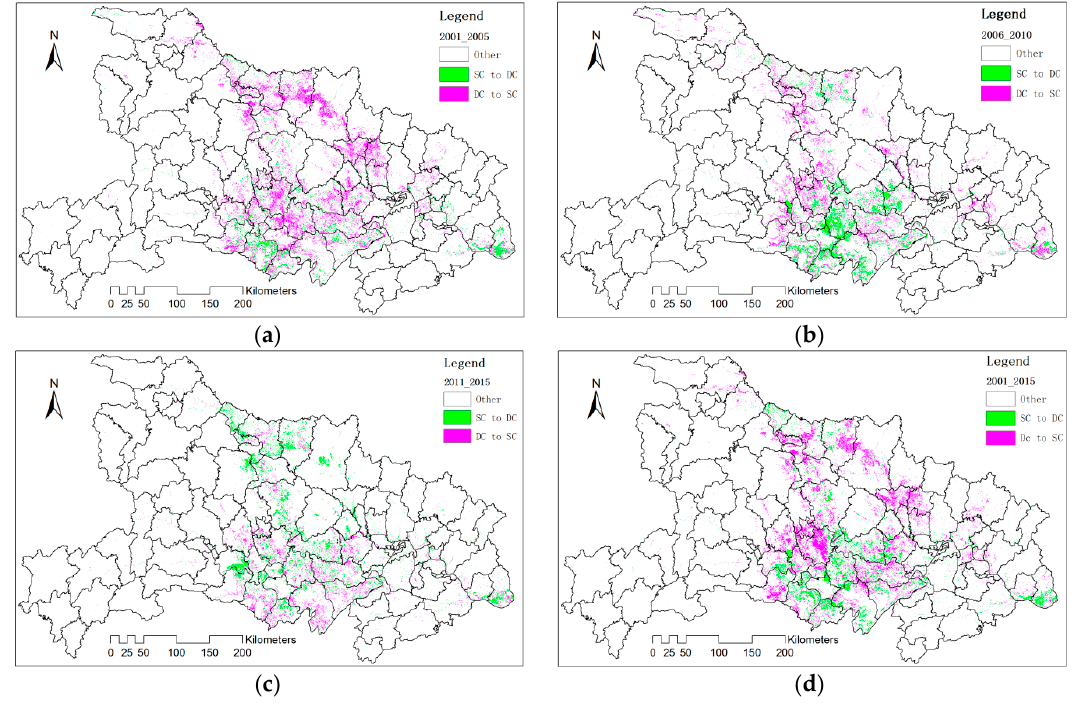
Figure 12. The transfer maps of SC and DC based on cropping frequency at five-year interval, ( a )